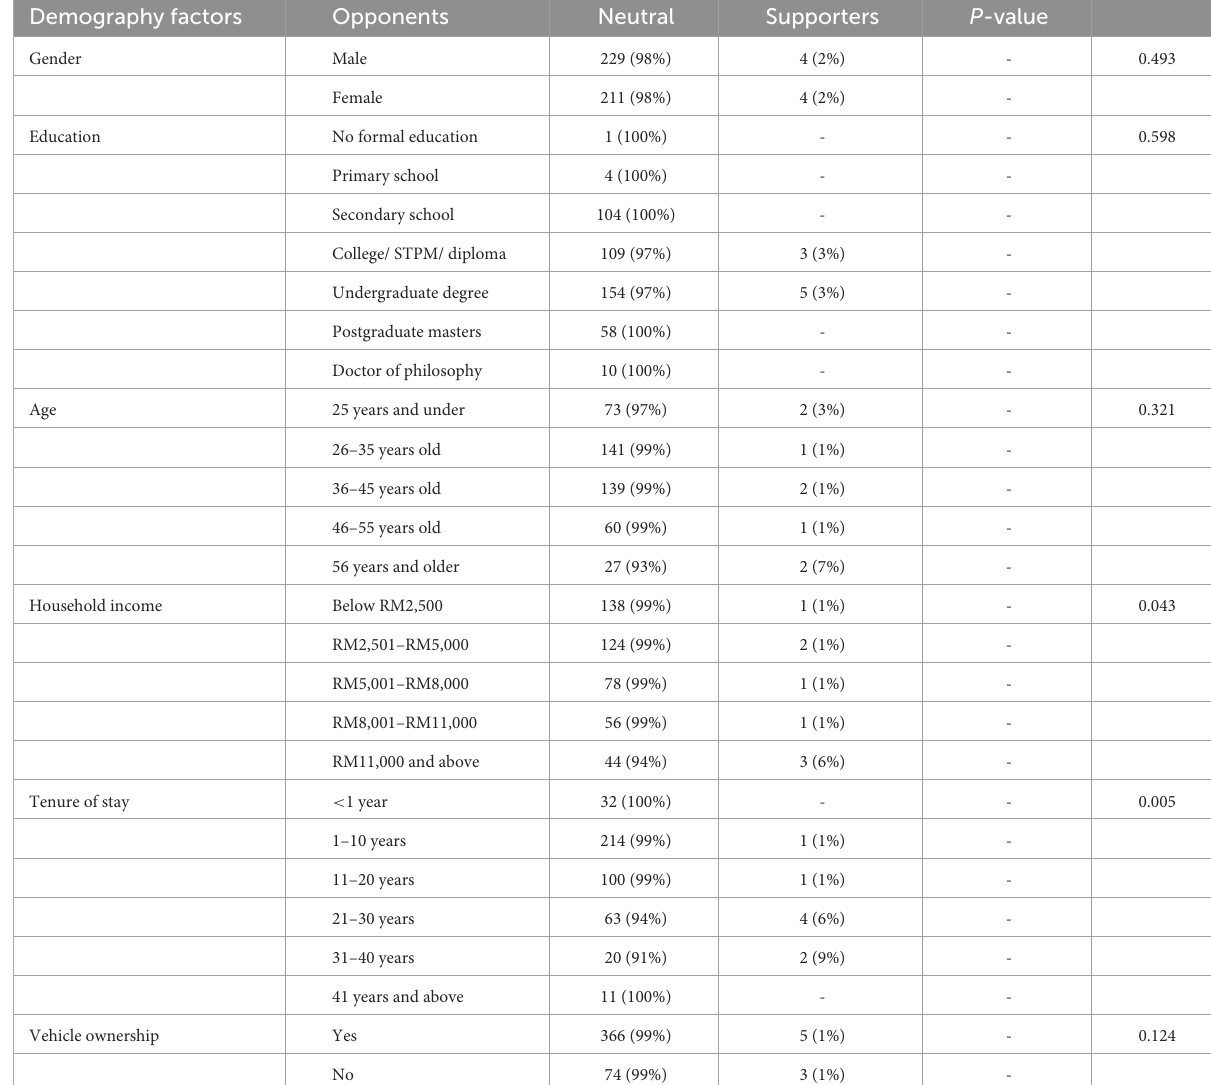
TABLE 4 Comparison between respondents supporting and opposing ELV management. Demography